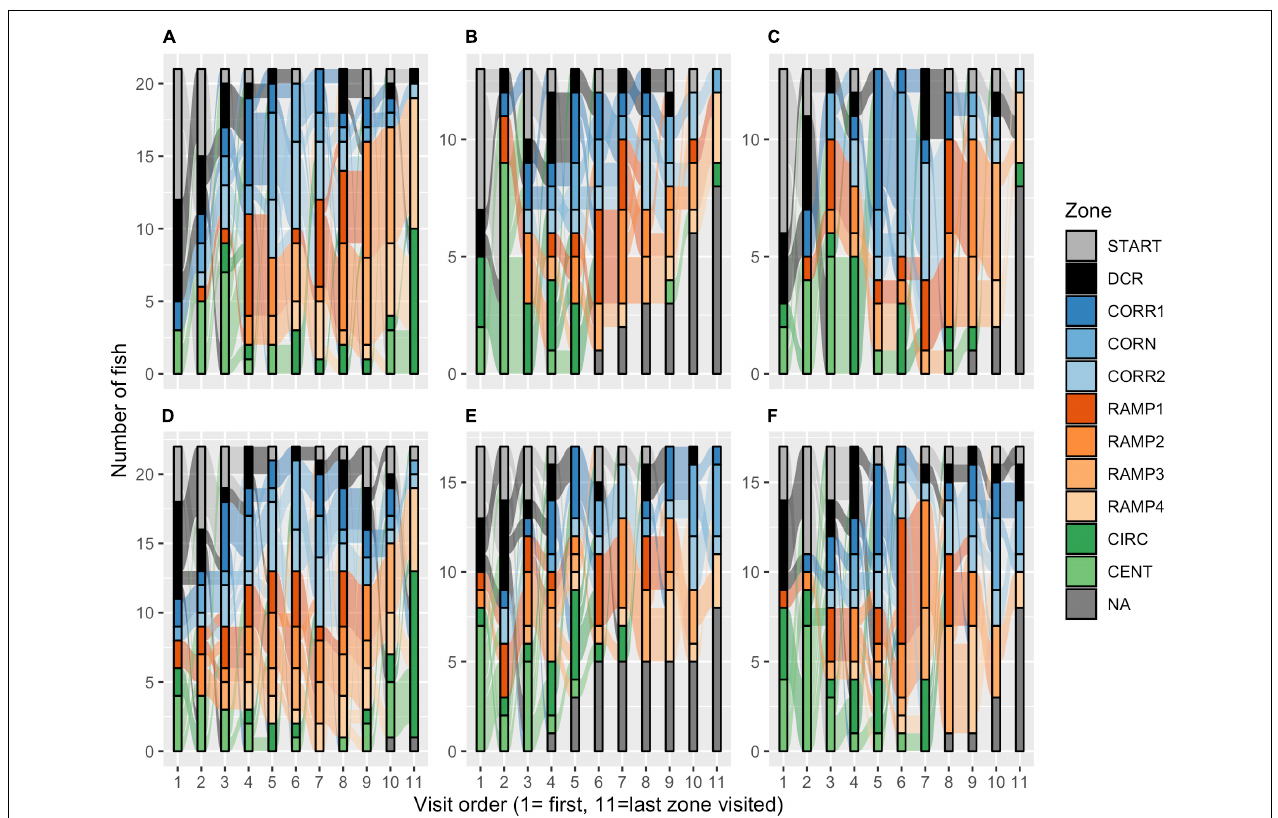
FIGURE 4 | Sankey diagrams of explorative strategies in the zMCSF test. The diagrams represent the order in which the zones were visited for (A) wild females, (B) AB females run 1, (C) AB females run 2, (D) wild males, (E) AB males run 1, and (F) AB males run 2. The height of each colored bar represents the number of fish that visited a particular zone as the n th novel zone they visited. The flows between the bars describe the number of individuals that moved from one zone to the next novel zone. The gray bars (“NA”) represent the number of fish that did not have an n th zone, i.e., they did not explore more than n -1 zones. Example: in (A) , seven wild females were first detected in DCR; 5 of those fish then went on to the START zone while the other two moved to CORR1. CENT, center; CIRC, central circle; CORN, corner; CORR, corridor; DCR, dark corner roof; REST, the part of the arena not designated to any other zone; F, female; M, male.